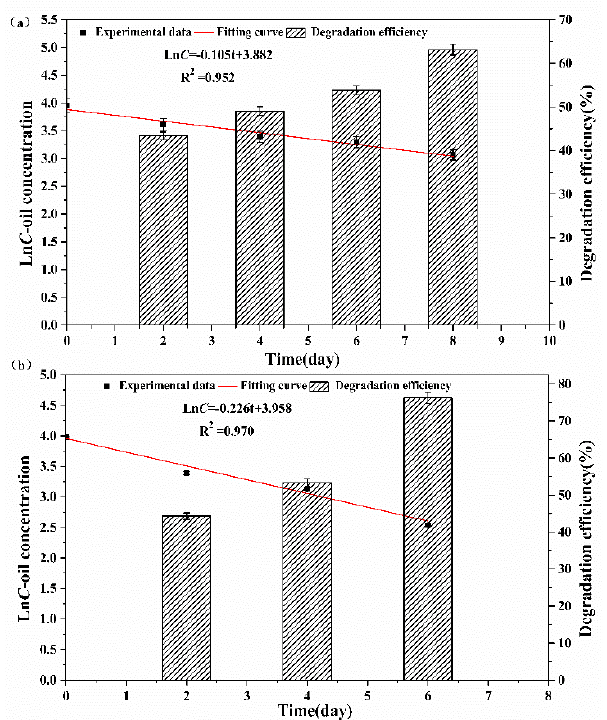
Figure 4. Degradation efficiencies and degradation kinetics of aromatic hydrocarbons for the ( a ) bacterial consortia and ( b ) laccase-bacterial consortia.